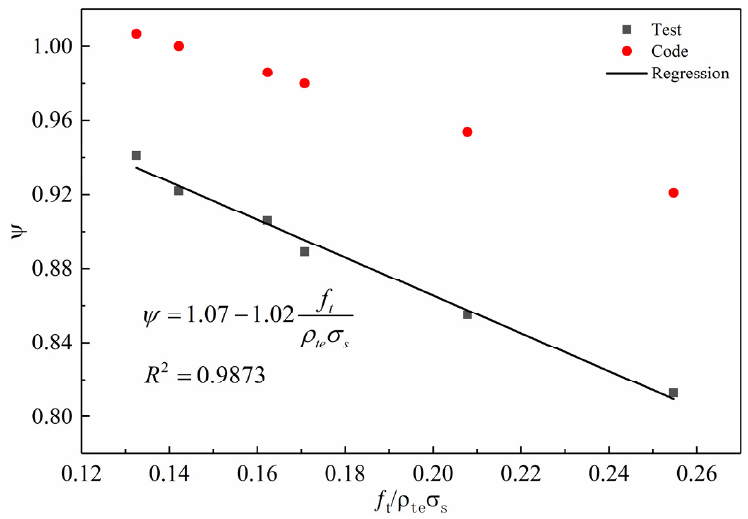
Figure 11. Regression of non-uniformity coefficient.